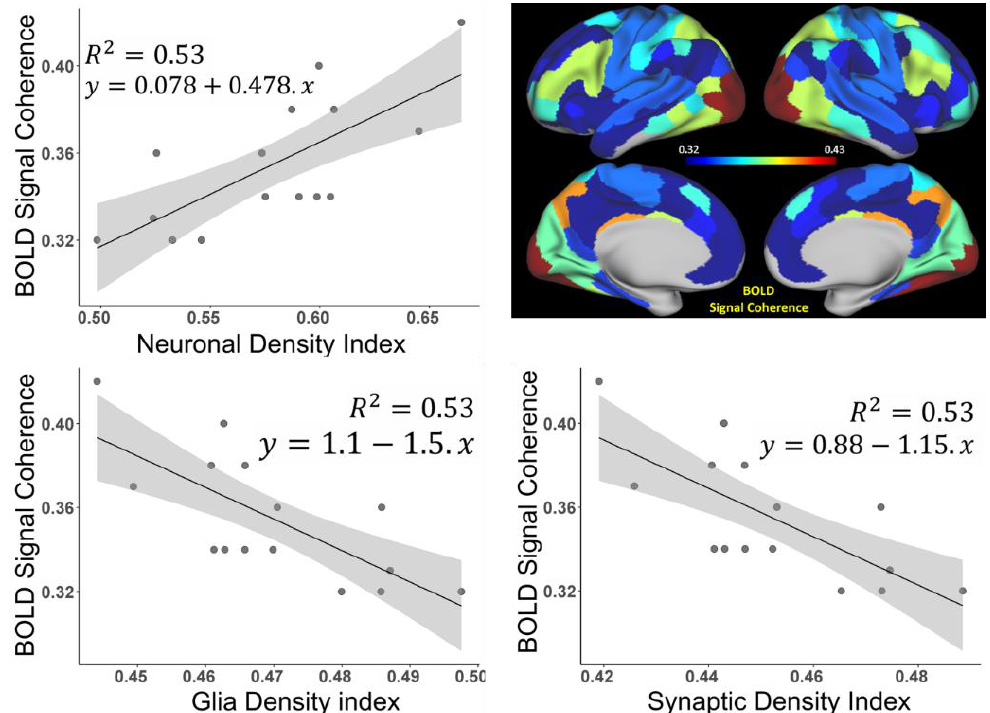
Figure 3. Association between the BOLD signal coherence in 15 networks and neural, glia, and synaptic density indices in